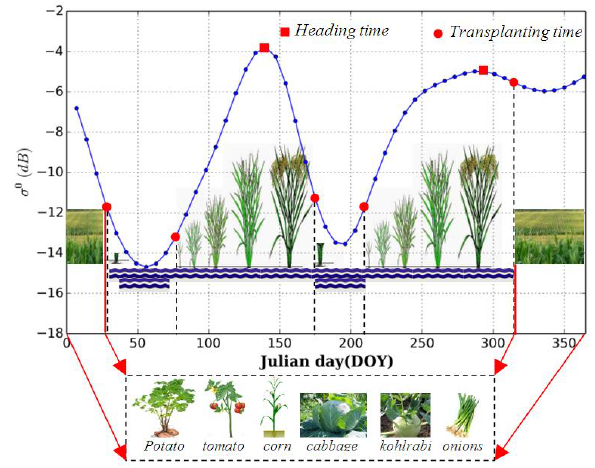
Figure 3. Double-cropped rice + winter main crop pattern plot based on 5 years ENVISAT ASAR WS backscatter data combination (rice plant image from the International Rice Research Institute (IRRI)-Rice Knowledge Bank)